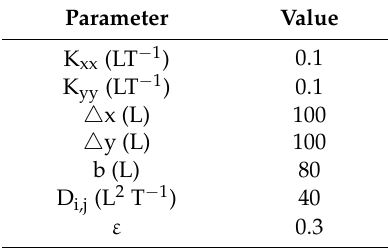
Table 2. Parameters of the groundwater flow and transport model.